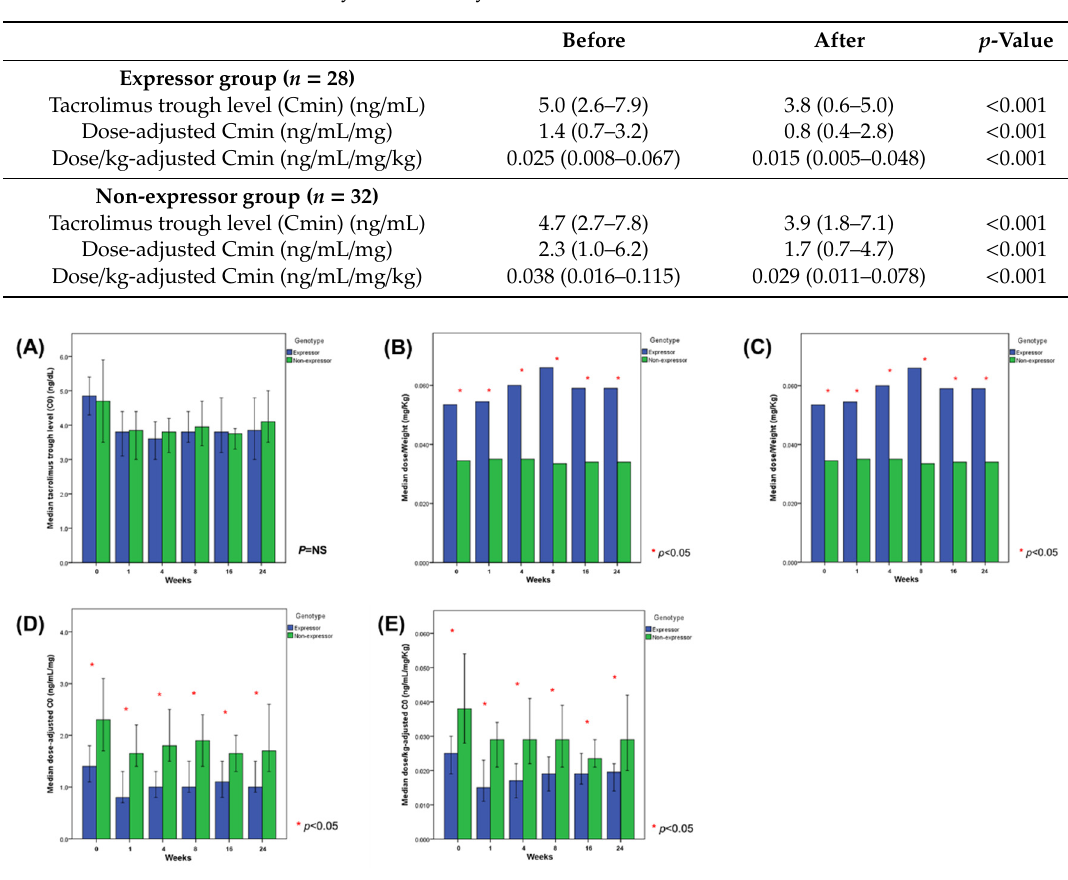
Figure 3. Tacrolimus exposure in CYP3A5 expressors and non-expressors determined during regular control visits in per-protocol set (medians with 95% confidence interval). ( A ) trough level of tacrolimus, ( B ) daily tacrolimus dose, ( C ) tacrolimus dose / weight, ( D ) dose-adjusted C0, and ( E ) dose / kg-adjusted C0. Table 2. Tacrolimus exposure parameters in CYP3A5 expressors and non-expressors before and after the conversion from twice-daily to once-daily extended-release formulation.